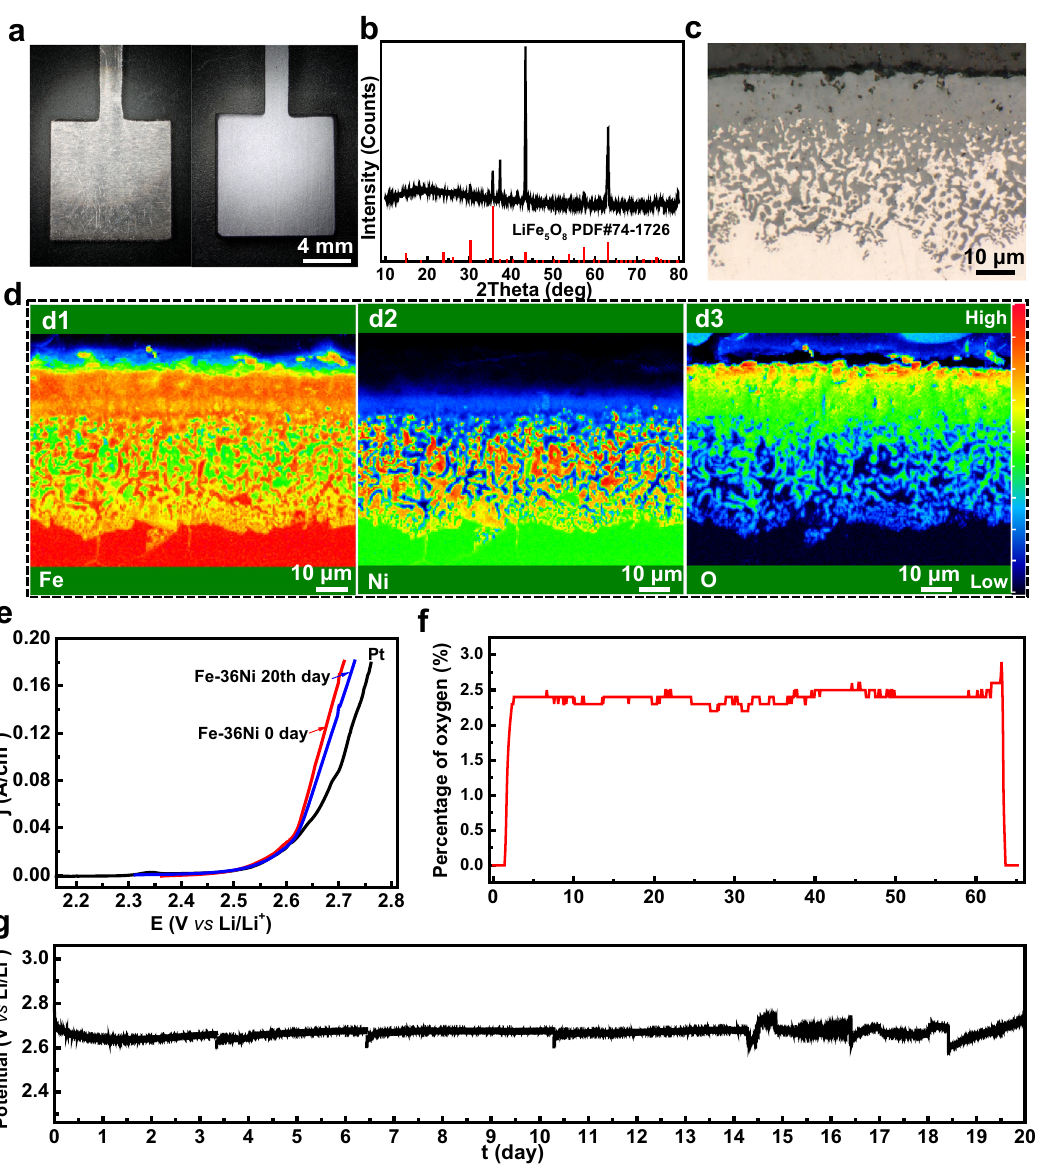
Fig. 3 | HT-OER performances of the Fe – 36Ni electrode in molten LiCl – Li 2 O at 650°C. a Optical graphs of the Fe – 36Ni anode before (left) and after pre-oxida- tion(right). b XRD pattern of the oxide scale. c Optical micrograph of the cross- sectionofoxidescale. d EPMAmappingofthecross-section(d1:Fe,d2:Ni,d3:O)of